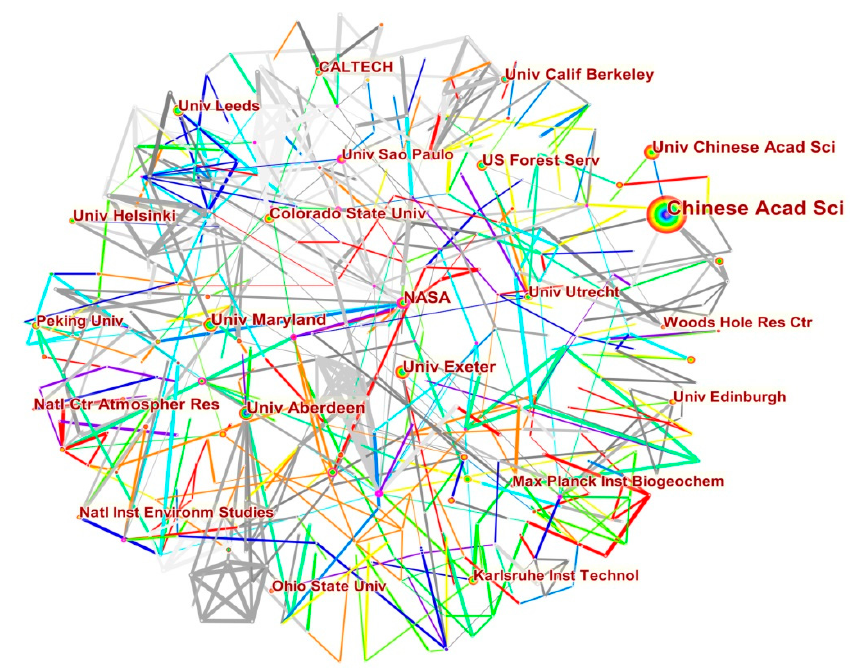
Figure 3. The cooperative network of carbon emissions research institutions based on the WoS database.